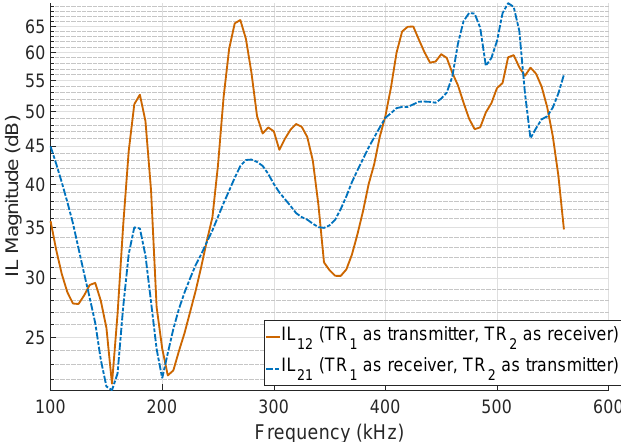
Figure 16. The measured insertion loss (IL) respect to the frequency in the communication between two transducers. The IL was measured one time with the preferential communication direction from the first transducer (TR 1 ) to the second transducer (TR 2 ) and one time from the TR 2 to the TR 1